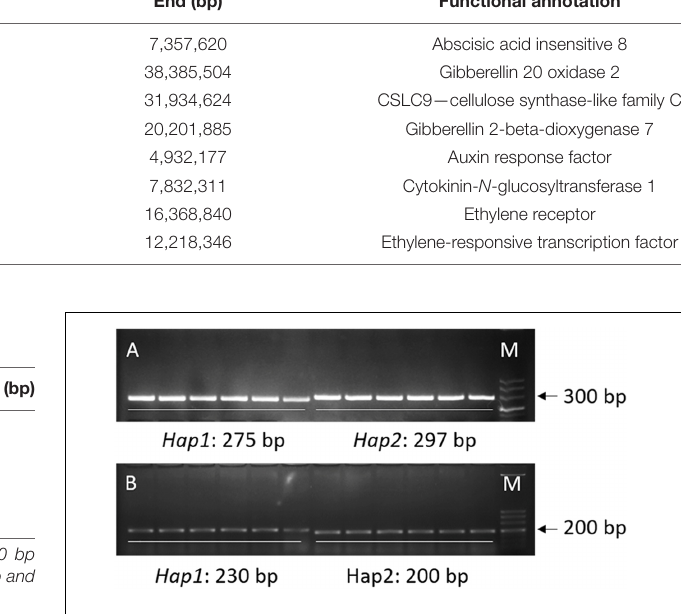
FIGURE 8 | Two PCR gel-based markers based on the 22-bp InDel at chromosome 1 and the 30-bp InDel at chromosome 7. (A) Marker Indel-Chr1:18932318 . (B) Marker Indel-Chr7:15404166